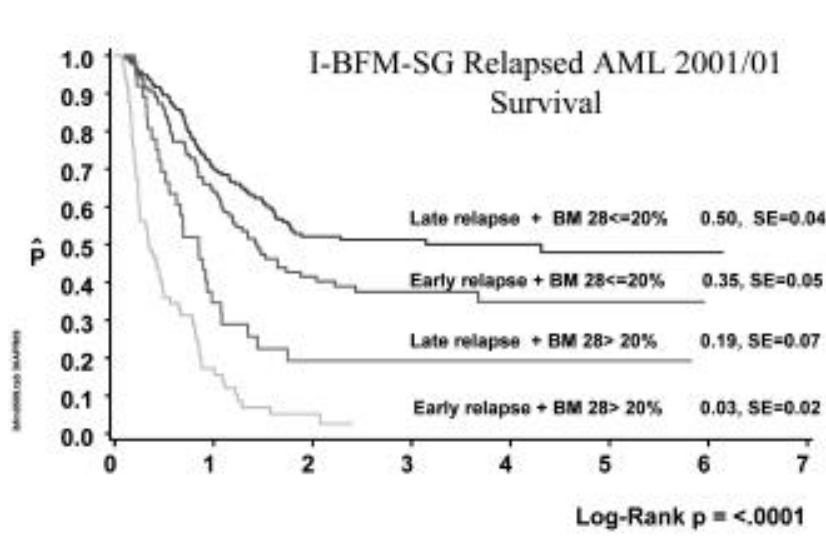
Figura 2 Sopravvivenza osservata nei 394 pazienti trattati con il protocollo I-BFM-SG Relapsed AML 2001/01 in base al tipo di recidiva (early=< 1 anno, late ≥1 anno dalla pri- madiagnosi) ed alla quota blastica midollare (< o ≥ 20%) rilevata al giorno 28 (good vs por response) dall’inizio del primo ciclo di terapia (Kaspers GJL et al. 12 ).